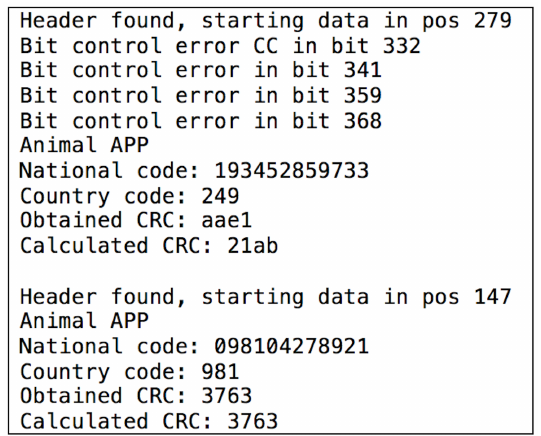
Figure 26. Example of readings from an animal identification